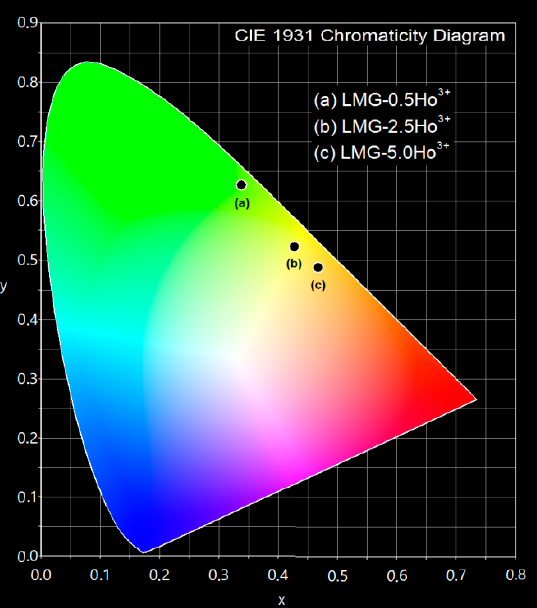
Figure 5. The influence of Ho 3+ concentration on chromaticity coordinates for Li 2 MgGeO 4 ceramics. Luminescence decays from the excited states of holmium ions in Li 2 MgGeO 4 ceramics were carried out to fully characterize the studied systems. It is clearly seen in Figure 6 that all registered decay profiles are nearly exponential, independent of the content of optically active dopants. Based on the decays, the luminescence lifetimes for the 5 F 4 + 5 S 2 ( λ em = 546 nm) and 5 F 5 ( λ em = 666 nm) levels of Ho 3+ were evaluated. The τ m values for LMG-Ho 3+ ceramics are nearly 10 µs ( 5 F 4 + 5 S 2 ) and 6 µs ( 5 F 5 ). Moreover, it was observed that this spectroscopic parameter is practically independent of the concentration of Ho 3+ ions in ceramic samples. The measured emission lifetimes for the 5 F 4 + 5 S 2 states of Ho 3+ in the LMG host are similar to fluorophosphate glass [6], but they are relatively lower compared to other reported glasses [7], ceramics [52], and crystals [53].